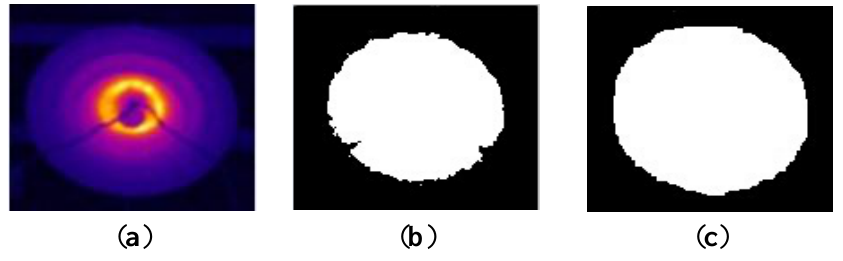
Figure 8. Result of image segmentation; ( a ) IR image of insulator; ( b ) Binary image after Otsu segmentation; and ( c ) Binary image after morphological